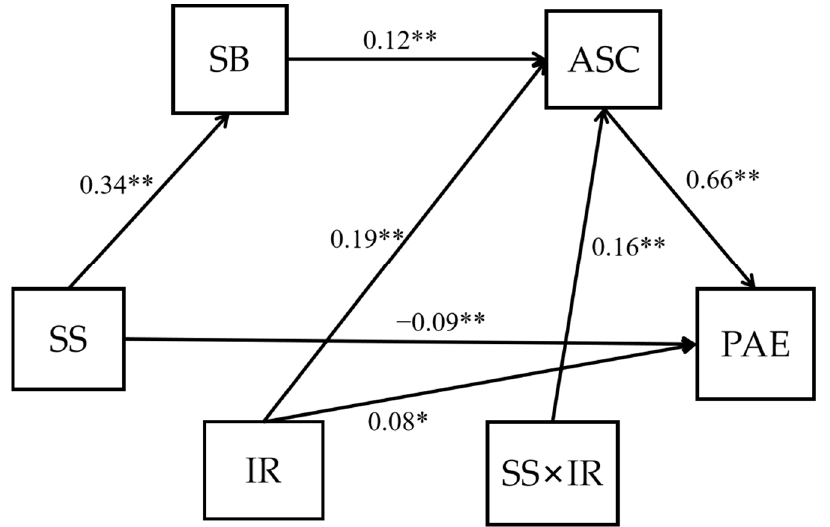
Figure 3. A diagram of the moderated serial mediation model, with positive achievement emotions as the dependent variable. SS—school status; SB—sense of school belonging; ASC—academic self-concepts; PAE—positive achievement emotions; IR—individual ranking; * p < 0.05; ** p < 0.01. Table 5. Moderated serial mediation results, with positive achievement emotions as the dependent variable. SS—school status; SB—sense of school belonging; ASC—academic self-concepts; PAE— positive achievement emotions.